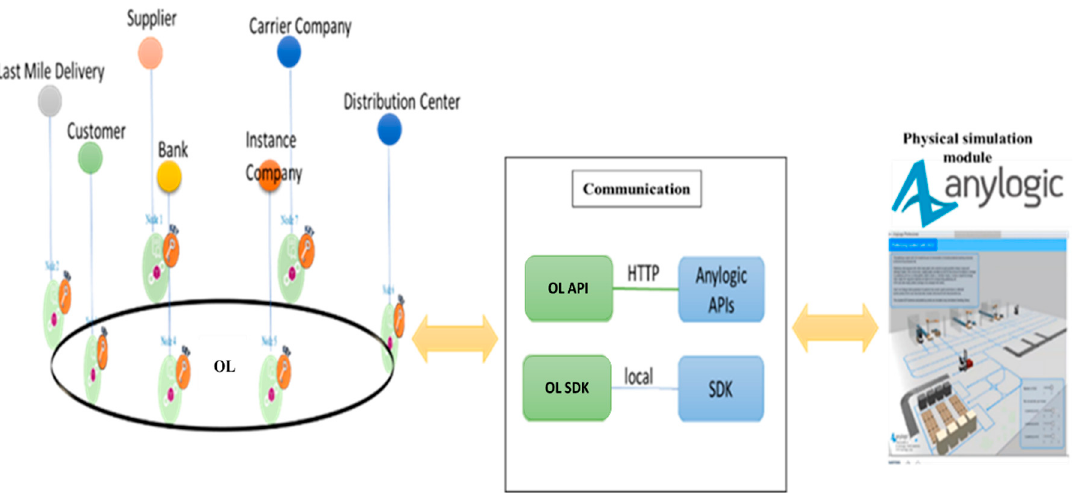
Figure 6. Develop a simulation platform .